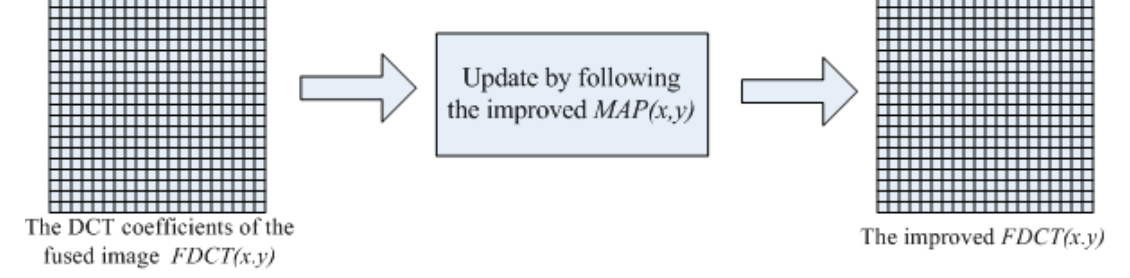
Figure 6. The improved FDCT ( x , y